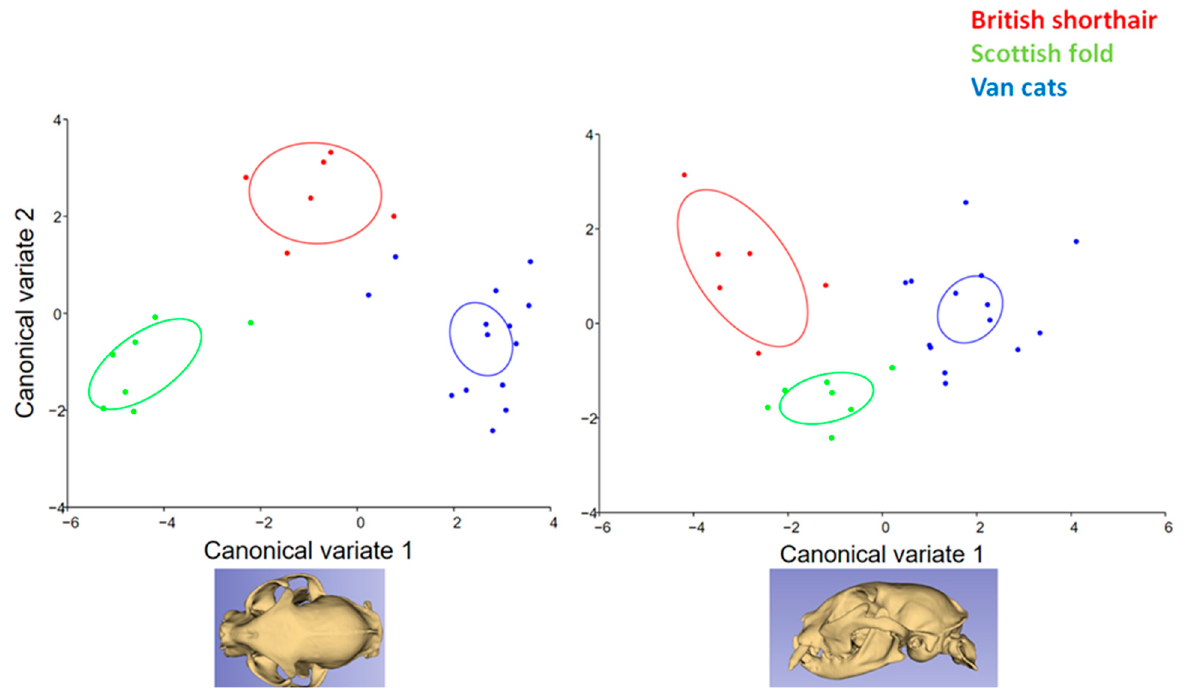
Figure 6. Frequency of distribution for CV1 and CV2 of cat skulls (n: 27) ( p < 0.0001 from 10,000 permutation rounds for procrustes distances among groups).